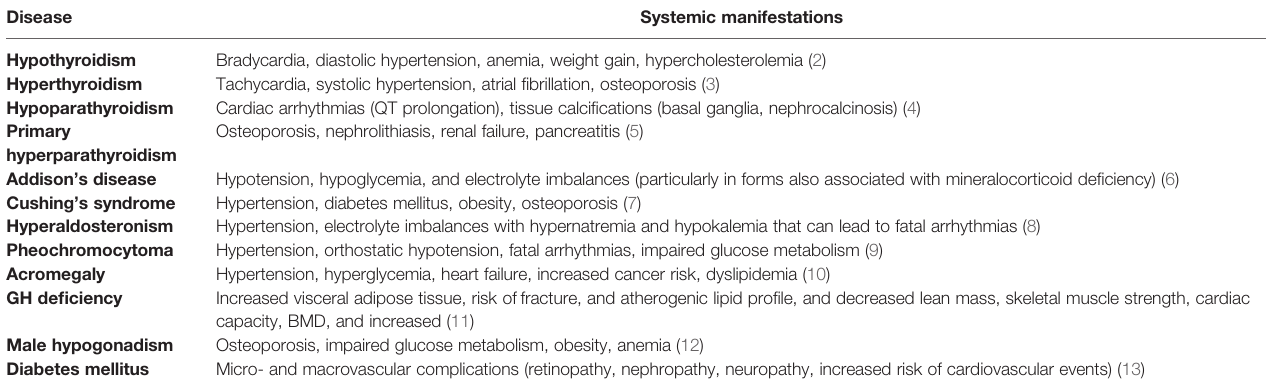
TABLE 1 | Systemic manifestations of the main endocrine diseases. Disease Systemic